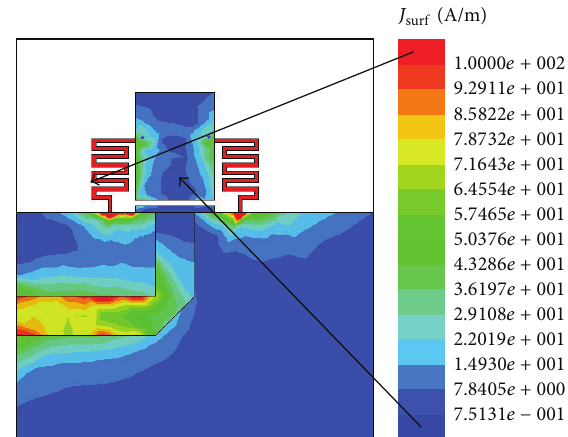
Figure 5: Surface current distribution on single antenna at 2.44